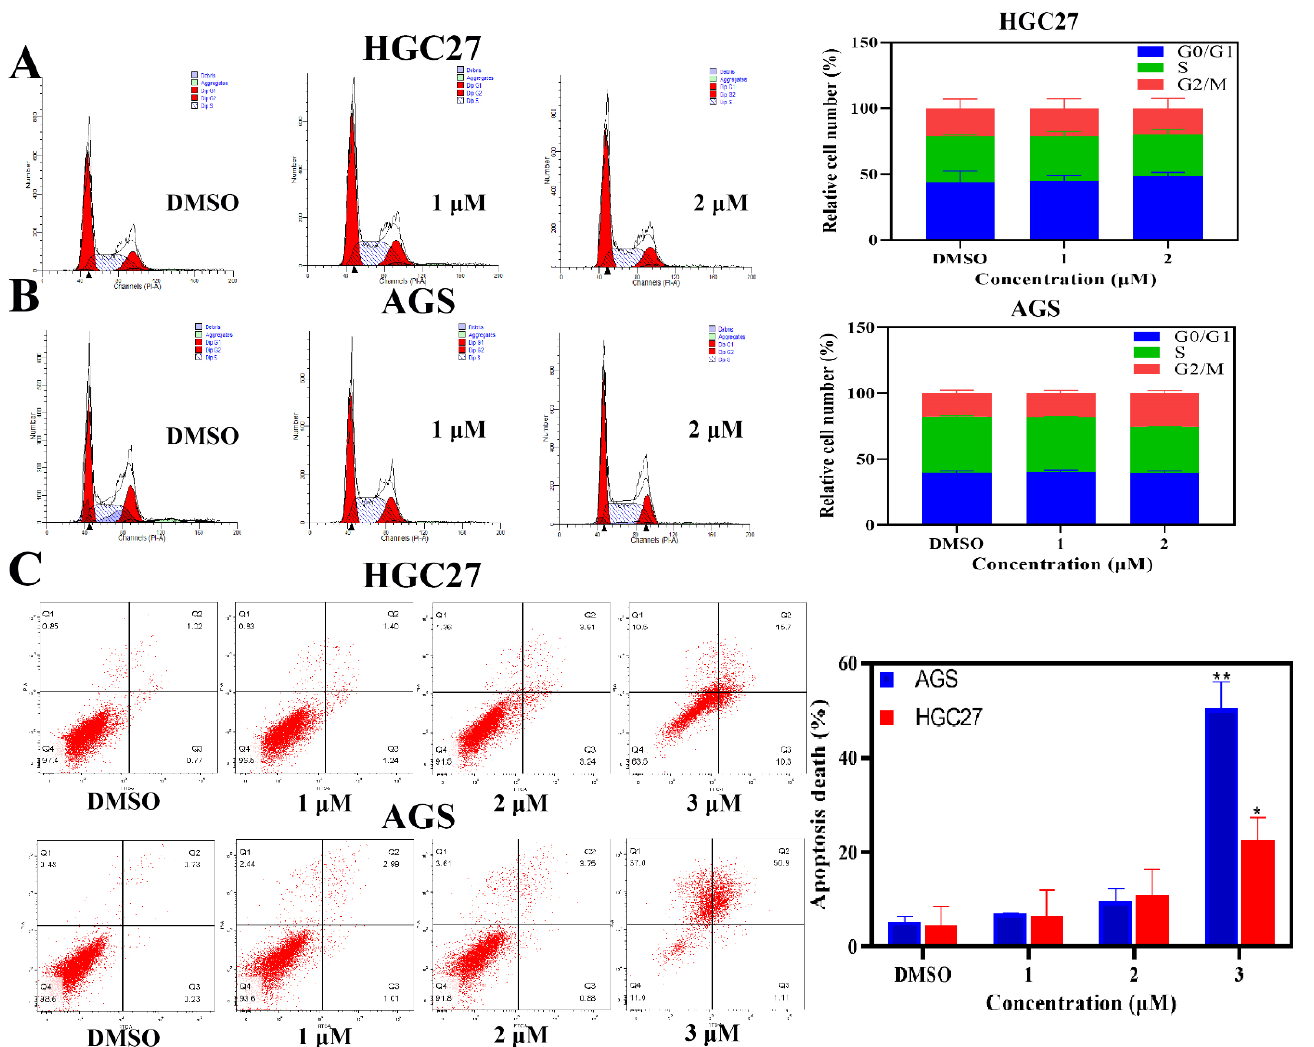
Figure 2. Cell cycle and apoptosis assays were tested with flow cytometry. ( A , B ) AGS and HGC27 cells were treated with BLG26 for 24 h and analyzed by flowed cytometry. ( C ) Analysis of cell apoptosis induced by BLG26 using Annexin V/PI assay. * p < 0.05, ** p < 0.01 compared with negative control.